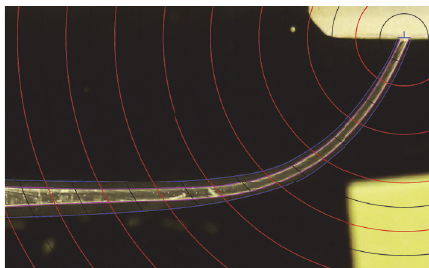
Figure 1: Reference points were built, constructing 9 concentric circlescenteringtheapexatincreasingdiametersof1 mm(redlines). To improve the accuracy of measurements, additional concentric circles were drawn starting at 0,5 mm from the apex at increasing diameters of 1mm (black lines).